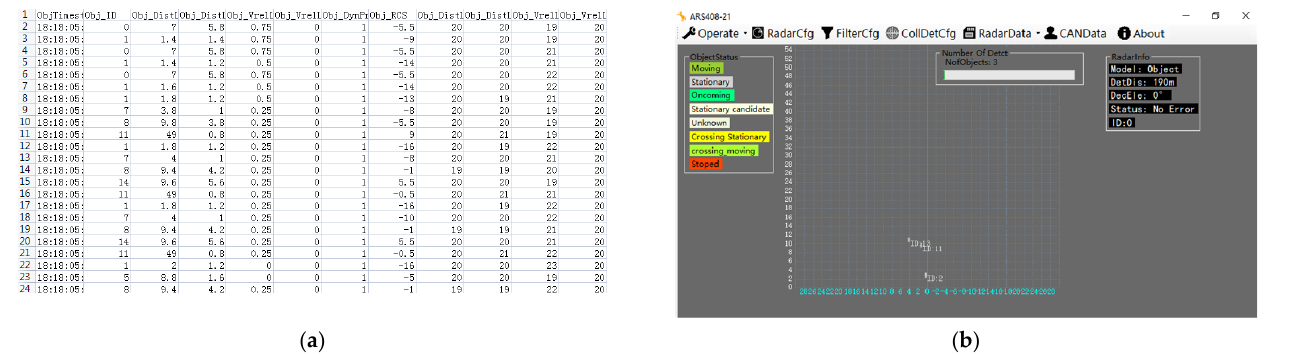
Figure 17. Radar raw data and visualization. ( a ) Initial video of the camera and data of the radar. ( b ) Visual interface of radar detection.